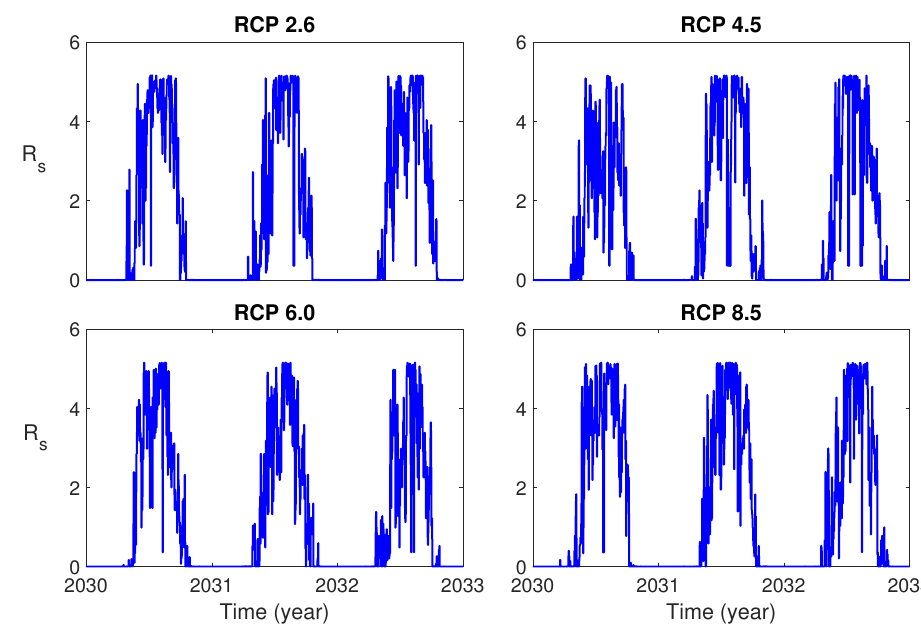
Figure 3. Plots of the seasonal reproduction number R s for Representative Concentration Pathways (RCPs) 2.6, 4.5, 6.0 and 8.5 during three